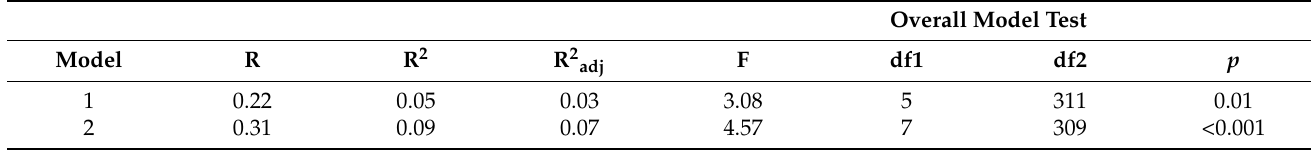
Table 12. Overall Model Test for Emotional